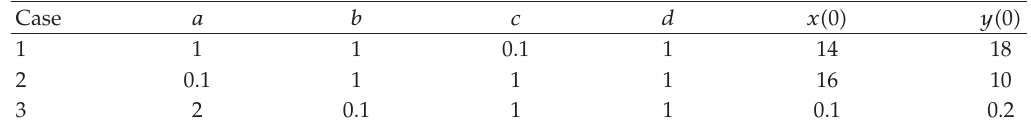
Table 1: Various